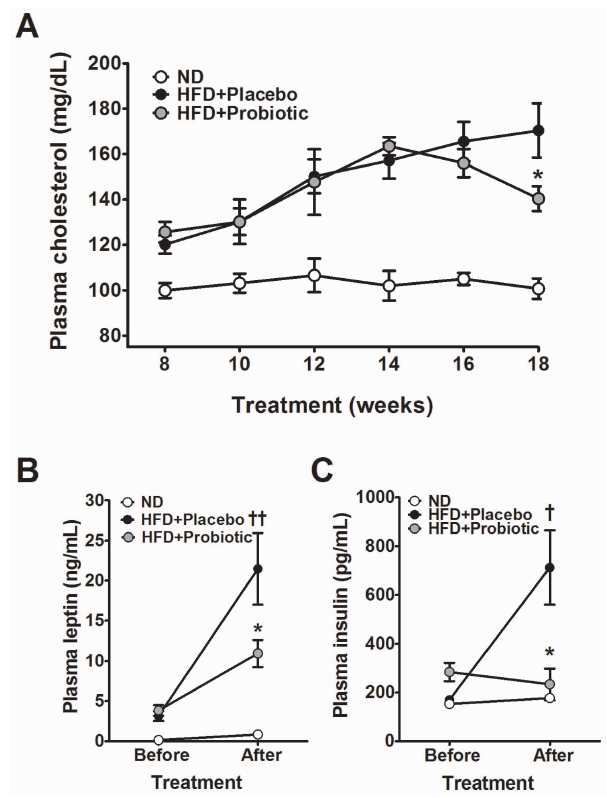
Figure 5. High-fat diet and probiotic effect on plasma cholesterol, leptin and insulin. Effects of probiotic treatment on (A) plasma cholesterol, (B) leptin and (C) insulin in diet-induced obese mice. Results are expressed as the means 6 SE. Significant differences between HFD-placebo versus ND are indicated as { p , 0.05, {{ p , 0.01. Significant differences between probiotic versus HFD are indicated as *p , 0.05.